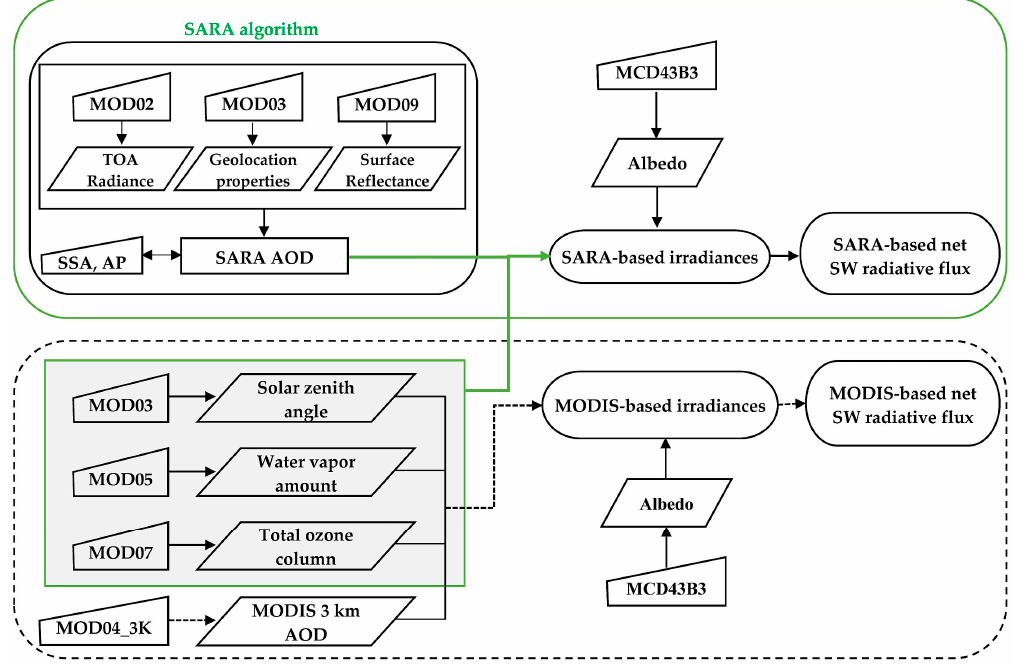
Figure 2. Framework showing the schemes of SARA- and MODIS-based shortwave (SW) radiative fluxes. The shaded area indicates the computation of transmittance factors shared by both schemes.